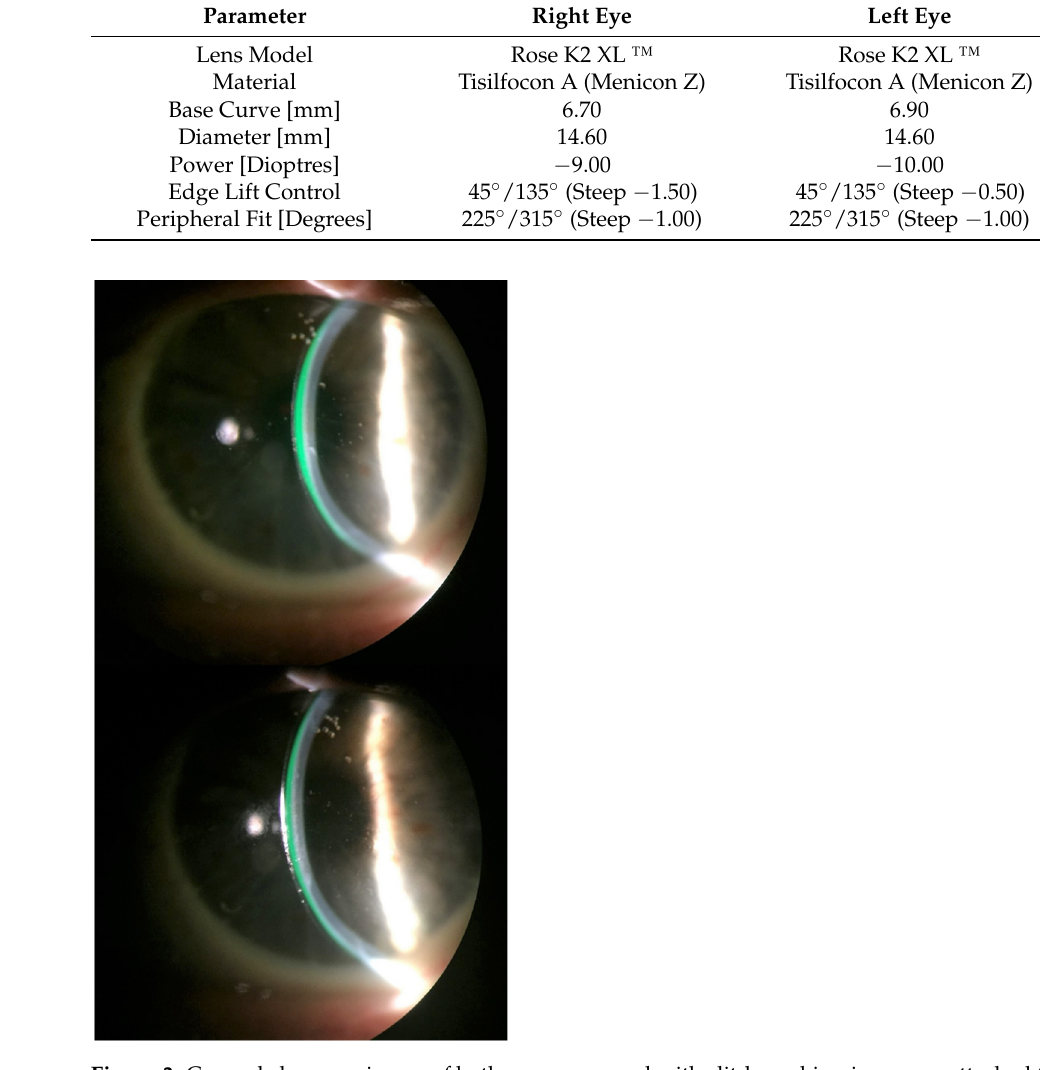
Figure 3. Corneal clearance image of both eyes measured with slit-lamp biomicroscope attached to a smartphone camera in January 2021. Right eye on the top (between 400 µm and 450 µm) and left eye on the bottom (between 300 µm and 350 µm).